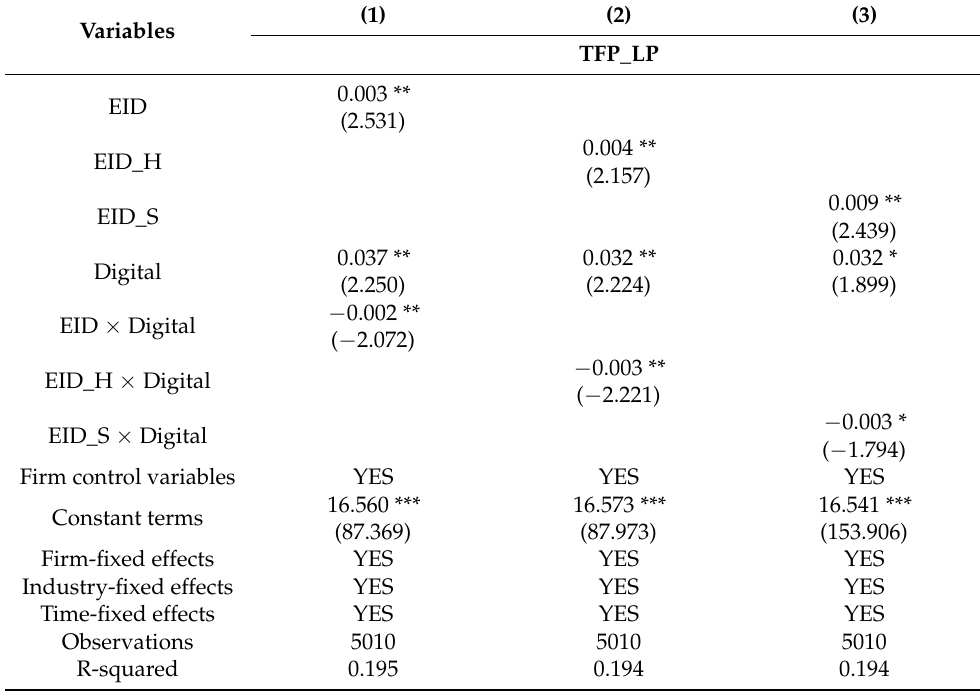
Table 8. Moderating effects: the tole of enterprise digital